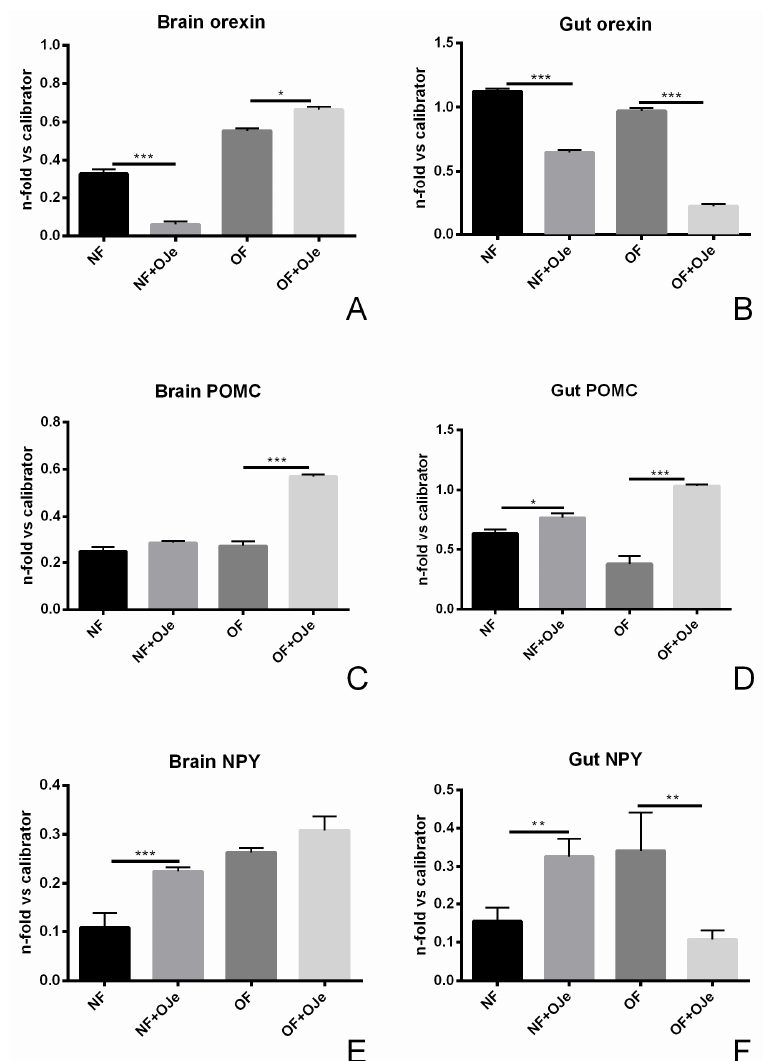
Figure 6. OJe is capable of modulating the expression of orexin, pro-opiomelanocortin (POMC), and neuropeptide Y (NPY). Brain ( A , C , E ) and gut ( B , D , F ) tissues from OJe-treated and -untreated fish were processed for qPCR analyses in order to investigate orexin ( A , B ), POMC ( C , D ), and NPY ( E , F ) gene expression. The levels of mRNA were calculated by the 2 − ∆∆ C t relative quantification method. Results are expressed as fold change in OJe-treated fish compared to those found in untreated ones, after normalization to β -actin. Data represent mean ± SD of five animals per each group. * p < 0.05, ** p < 0.01, *** p < 0.001 vs. respective counterparts.